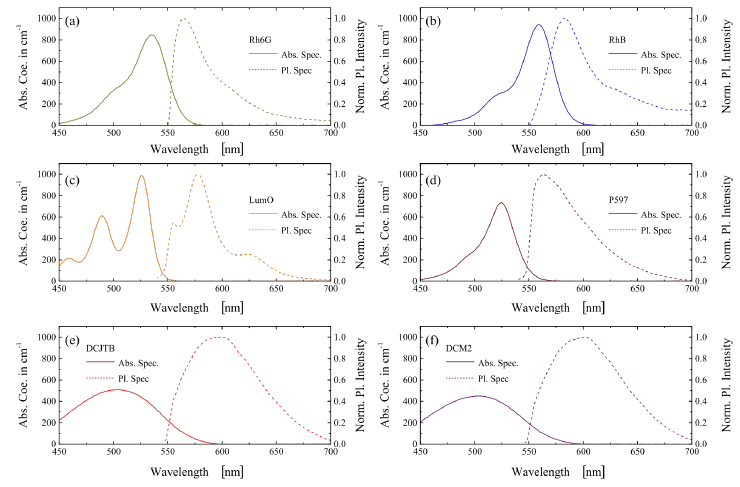
Figure A1. The absorption spectra and the emission spectra of dye-doped PMMA were